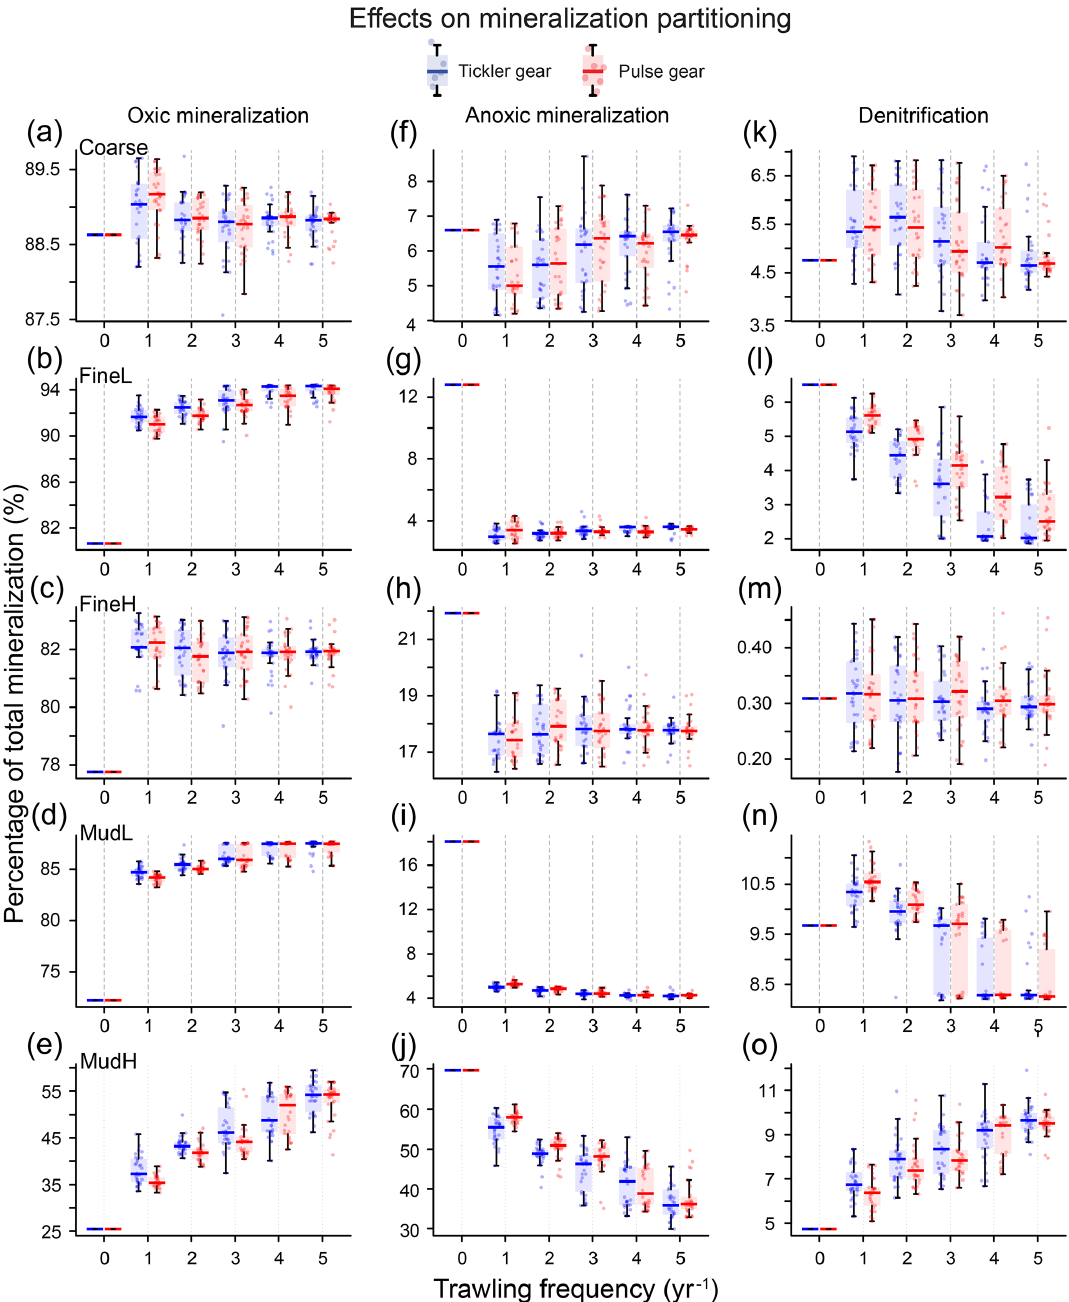
Figure 8. Relative contributions ( y axis, as proportion) of the three main mineralization processes ( a–e : oxic; f–j : anoxic; f–o : denitrification) to the total mineralization for each gear type (blue boxes: tickler gear; red boxes: pulse gear) and for increasing trawling frequency ( x axis, yr − 1